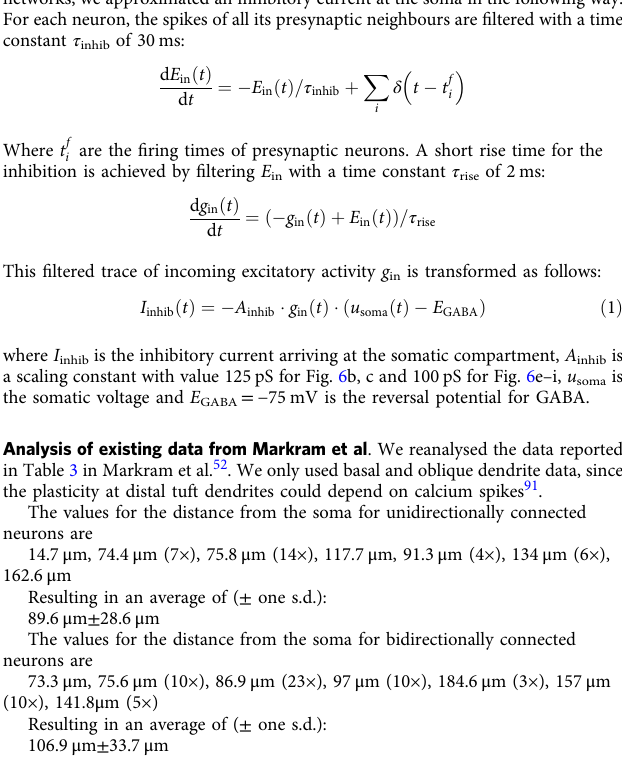
Figure 1 . Figure 1a : 17 distal and 17 proximal compartments in the neuron model are identi fi ed. The distal compartments are further split into two groups: one group consists of distal compartments eliciting NMDA spikes when activating synaptic input as described for Fig. 1b below, and the other group consists of compartments where no NMDA spike is elicited with such input. We considered an NMDA spike to be evoked if the local depolarisation crossed a threshold at − 15mV. Using this criterion, 12 out of the 17 distal compartments where classi fi ed in the fi rst group